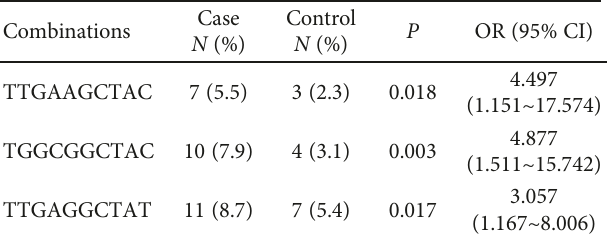
Table 5: Combinations of genotyped SNPs in IL23R , IL17A , IL17F , TNFa , ROR γ t , and STAT3 showing signi fi cant di ff erences between PF patients and